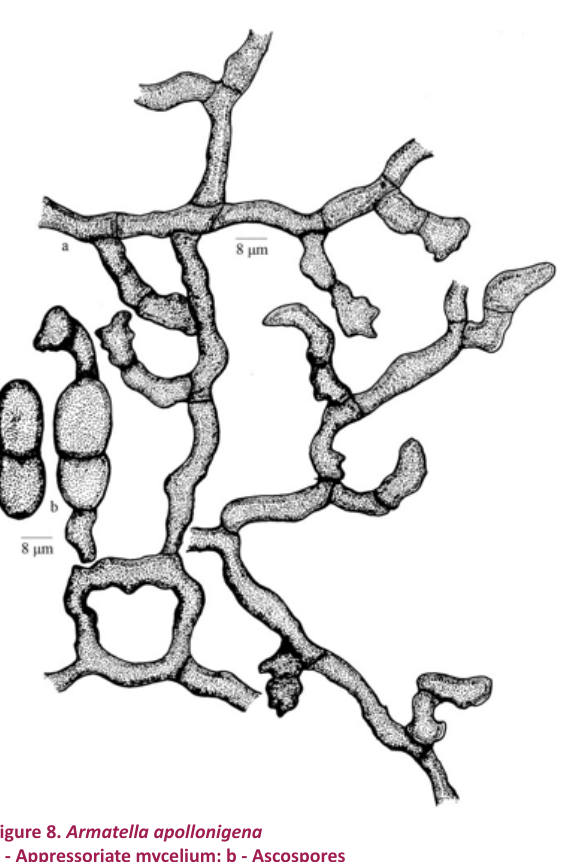
Figure 8. Armatella apollonigena a - Appressoriate mycelium; b -